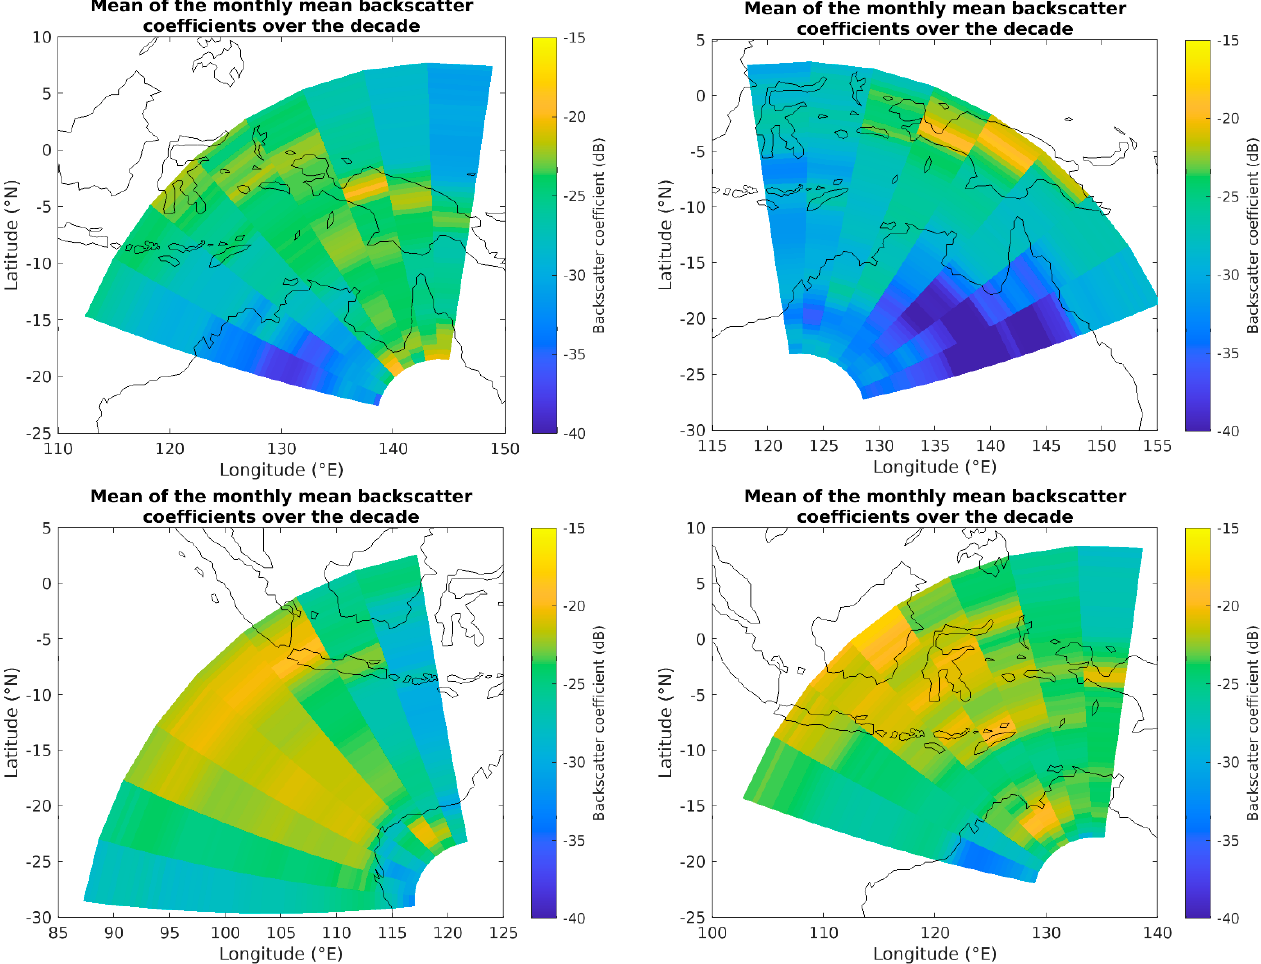
Figure 7. Decade mean of the monthly mean backscatter coefficients for LO ( top left ), LAE ( top right ), LAW ( bottom left ) and AS ( bottom right ).